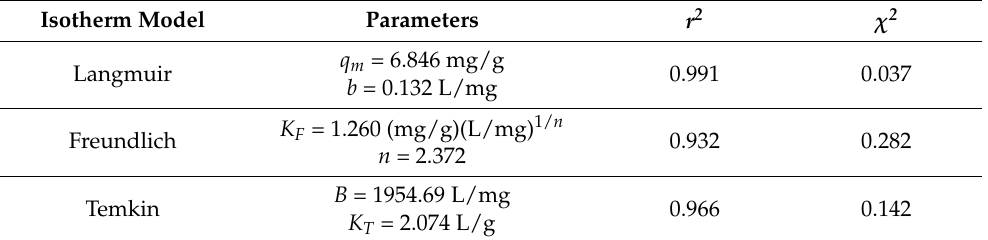
Figure 4. Adsorption isotherm and nonlinear fitting models of ciprofloxacin onto GO/Ca-Alg 2 – PAM beads. Table 1. Parameters, regression coefficients ( r 2 ), and chi-square ( χ 2 ) of ciprofloxacin adsorption isotherm models using GO/Ca-Alg 2 –PAM beads.